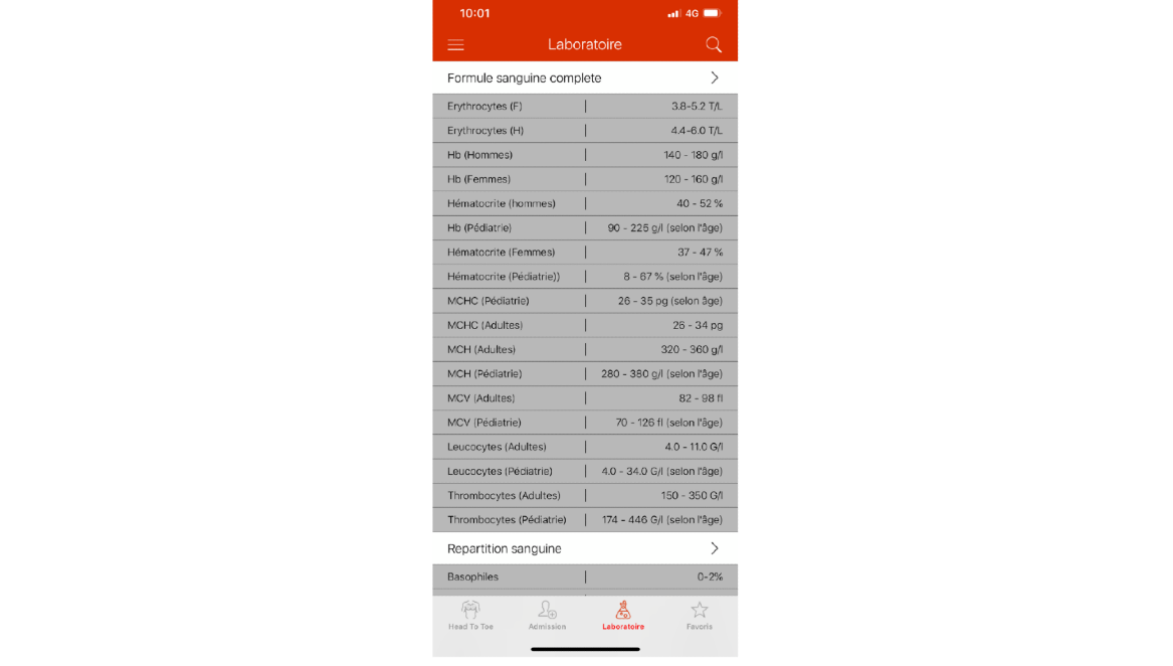
Figure 3. History-taking and clinical examination checklist section in the HeadToToe plaform (in French). Users can consult the list, add comments, and create a PDF with all checked items and added information.